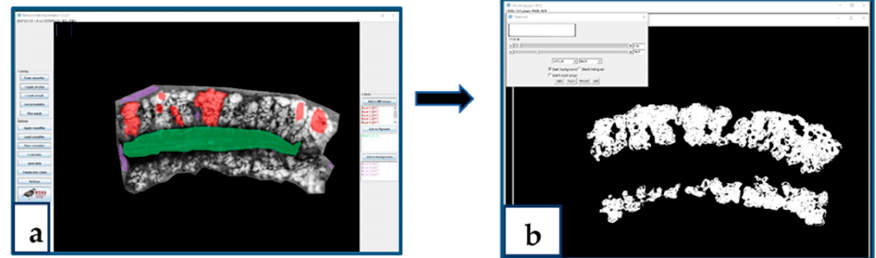
Figure A2. Classifiers are applied and segmentation ran ( a ) and the first probability map with a threshold for further quantitative analysis ( b ).